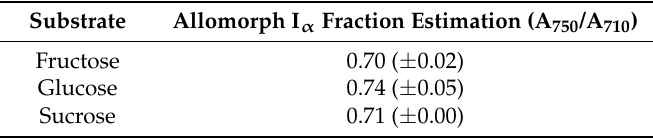
Table 3. I α fraction estimation in each BC produced from the evaluated culture media.